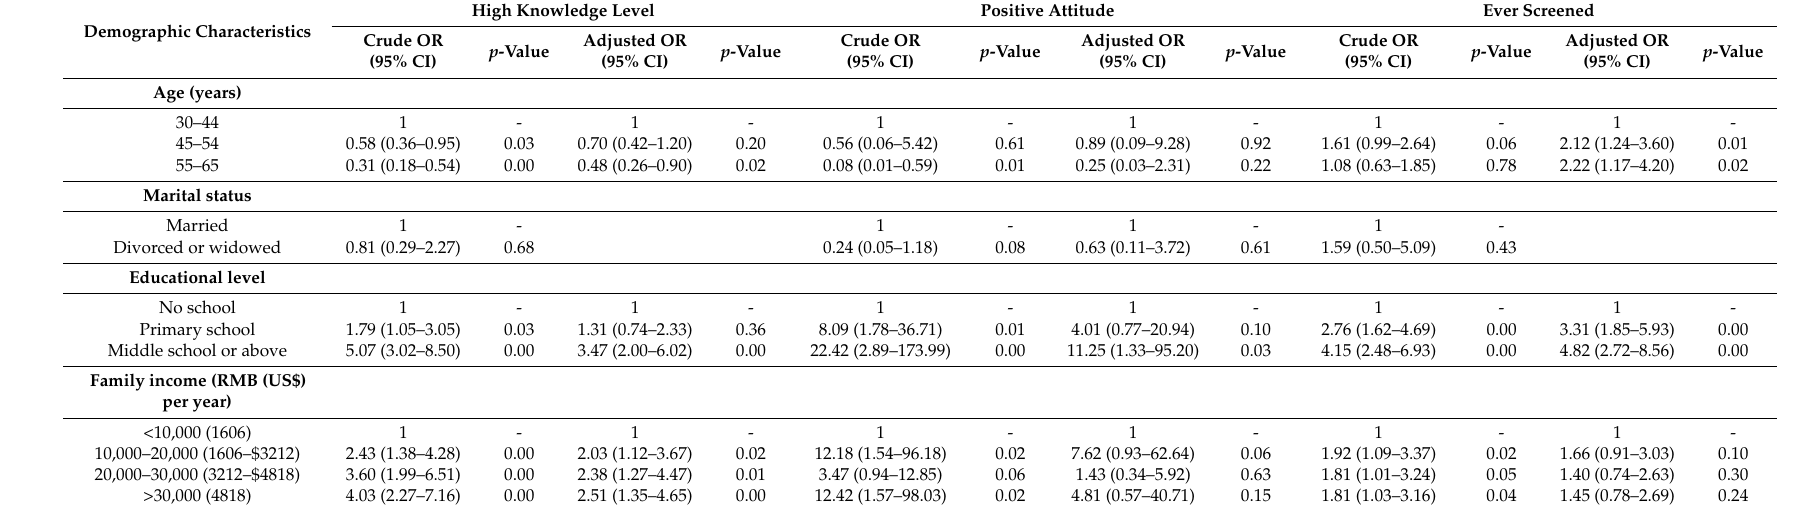
Table 5. Associations of the adequacy of knowledge, attitude towards cervical cancer and its screening with socio-demographic characteristics.